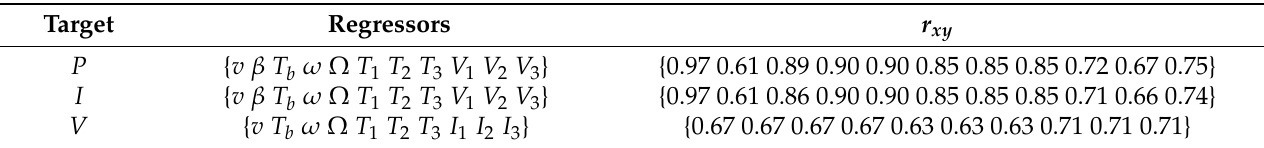
Table 1. Selected features for the normal behavior models and Pearson coefficient r xy with the target: D train data set. Target